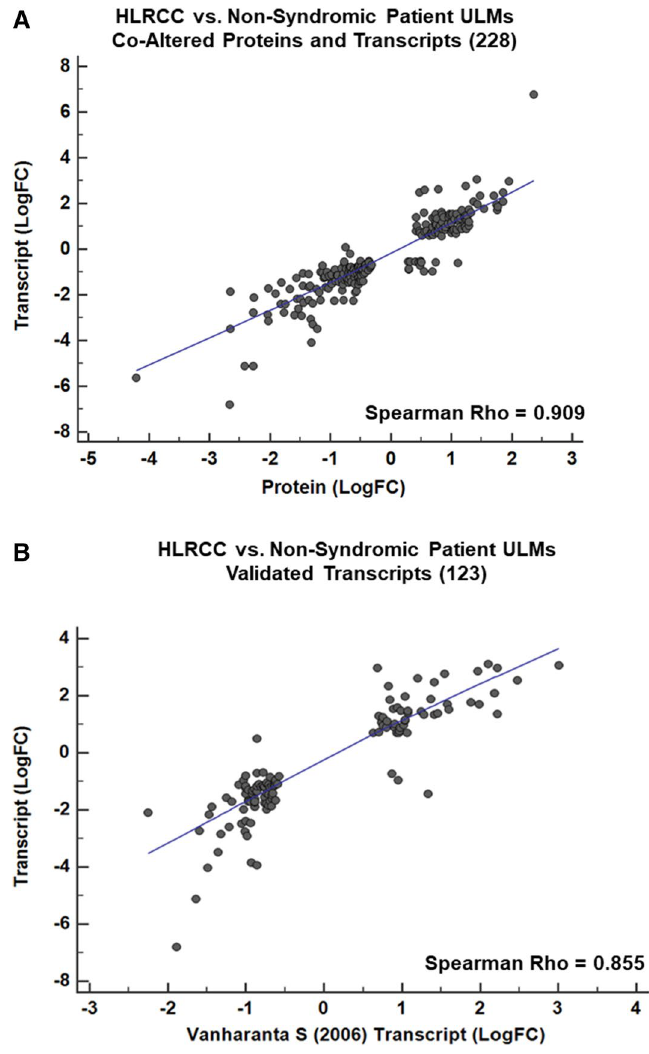
Figure 5. Correlation plot of co-altered proteins, transcripts and validated transcript alterations in Hereditary Leiomyomatosis and Renal Cell Cancer (HLRCC) and non-syndromic (NS) patients. ( A ) Correlation plot reflects 228 co-altered proteins and transcripts significantly altered between HLRCC and NS ULMs (Spearman Rho = 0.909, MWU p < 0.0001). ( B ) Correlation plot reflects 123 transcripts co-altered in our dataset and Vanharanta et al. 20 (Spearman Rho = 0.855, MWU p <